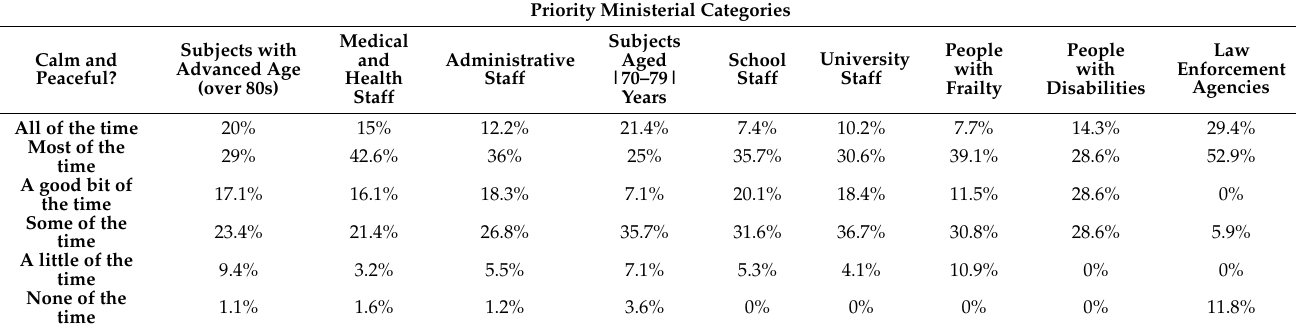
Table 3. Percentage of response frequencies related to item #9 of SF-12 divided by vaccine priority ministerial